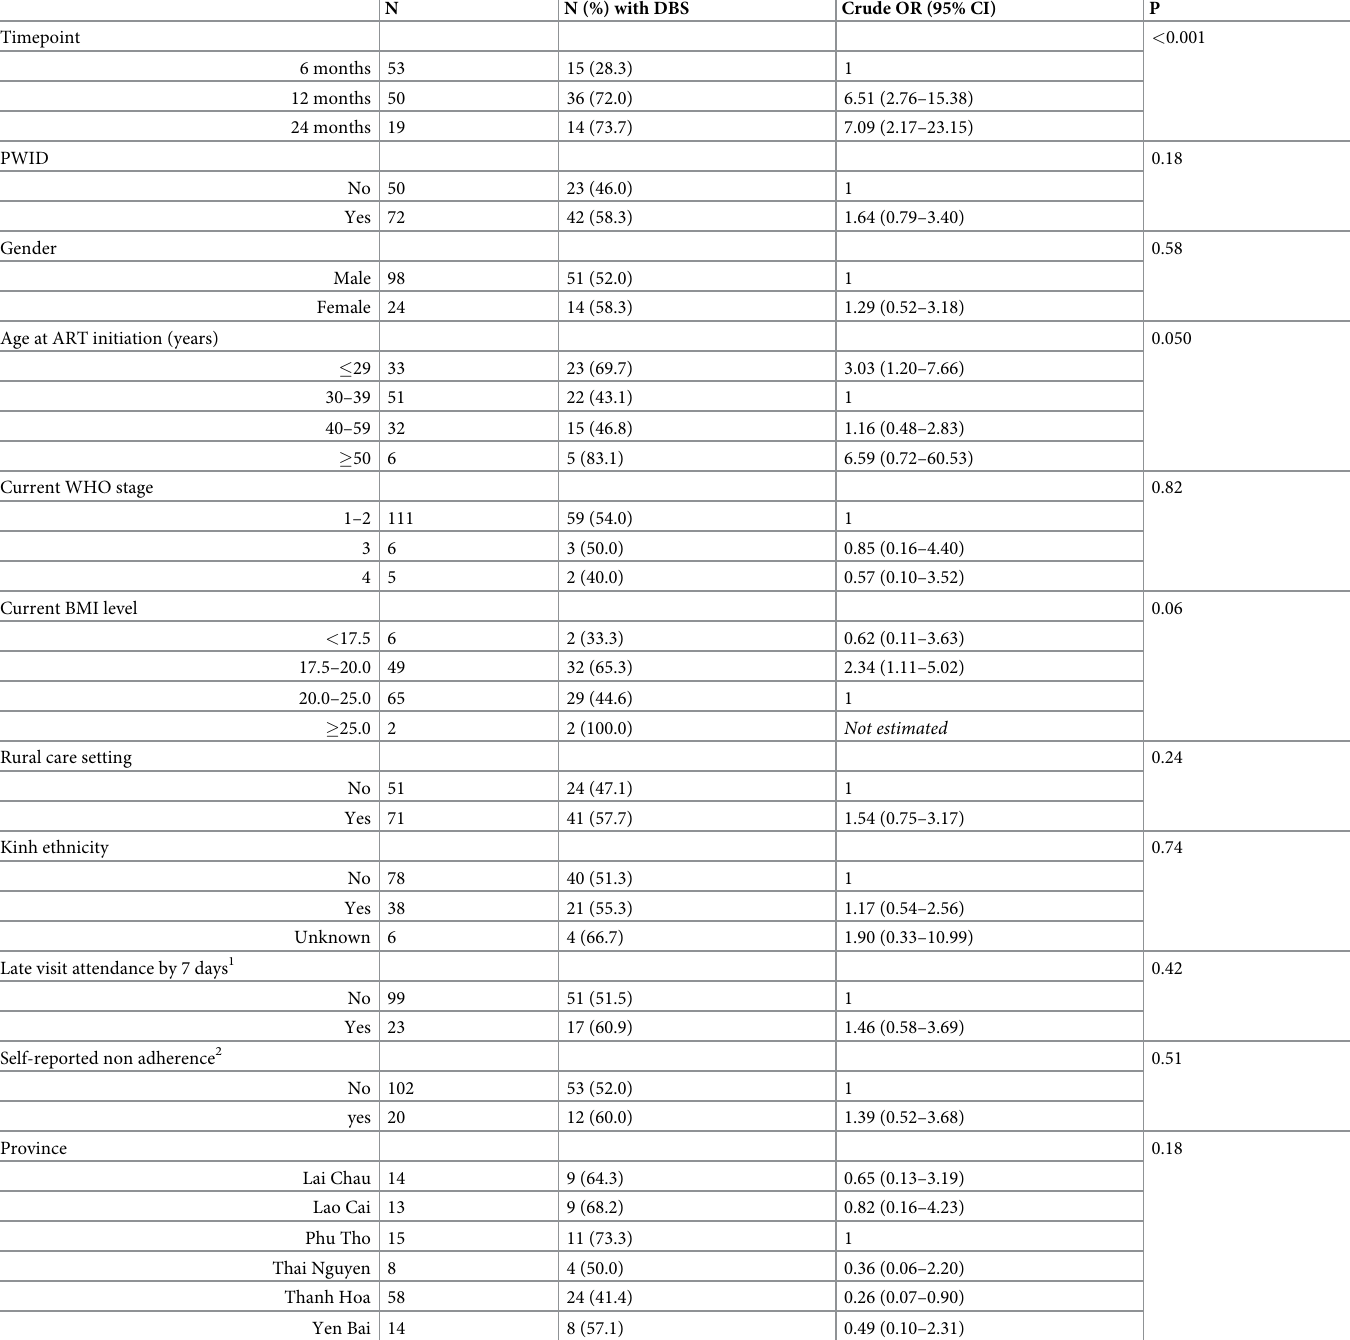
Table 5. Factors associated with DBS availability to confirm virological failure (mixed-effects logistic regression). N N (%) with DBS Crude OR (95%